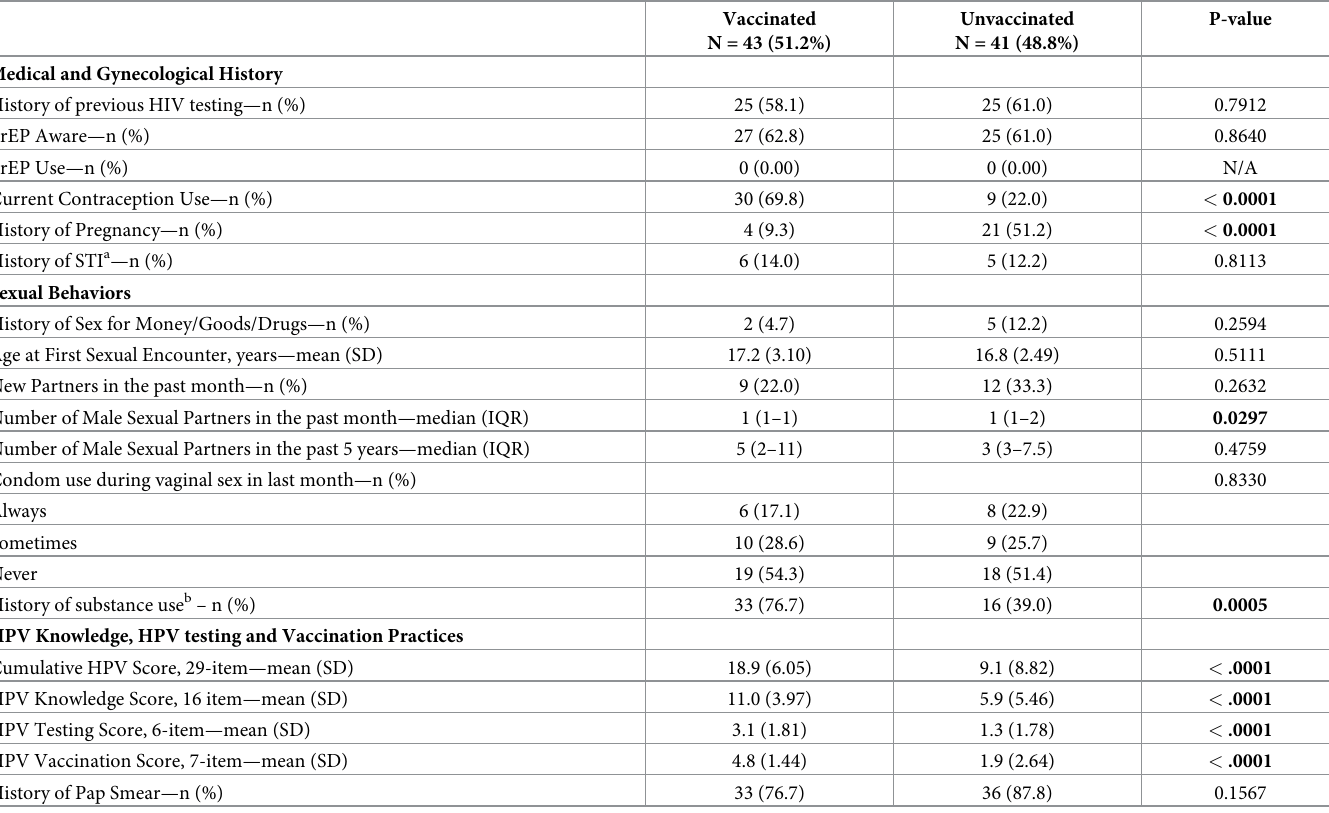
Table 2. Medical and gynecological history, sexual behaviors, hpv education & practices among study participants (N =